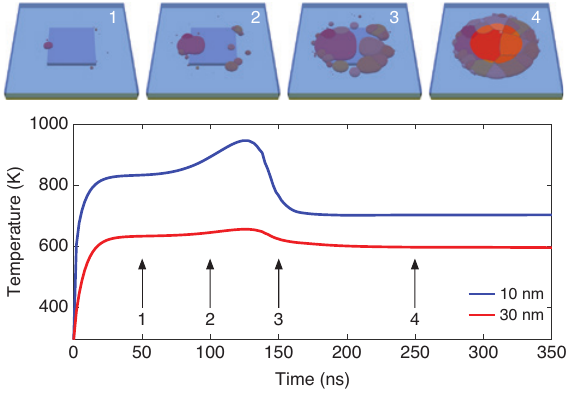
Figure 4: Crystalization steps and temperature evolution. Temperature evolution at two depths in the GST layer (10 and 30 nm from the top surface of the GST layer) in the center of the illuminated area. Top panels 1–4 show the distribution of the crystalline phase at the marked times. The buffer layer is shown in green. The square antenna is shown in gray. Blue semi-transparent volume represents the amorphous phase. Other colors code different crystalline phase